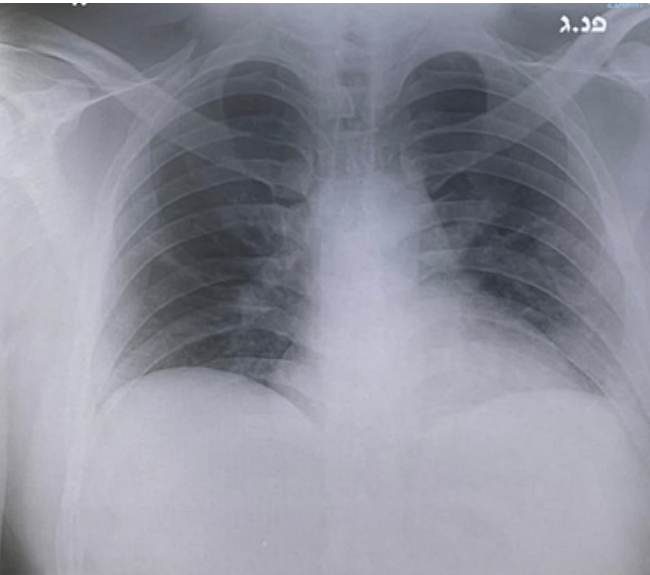
Figure 2. Chest X-ray after convalescent plasma showing significant resolution of the pulmonary infiltrates.